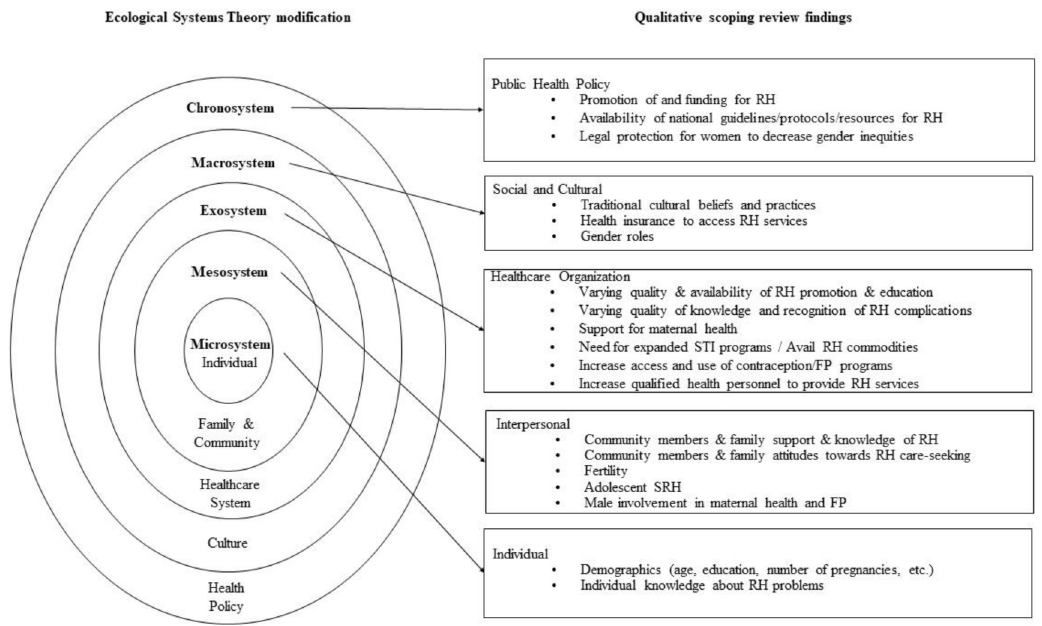
Fig 3. Our adaptation of the ecological systems theory to characterize reproductive health in